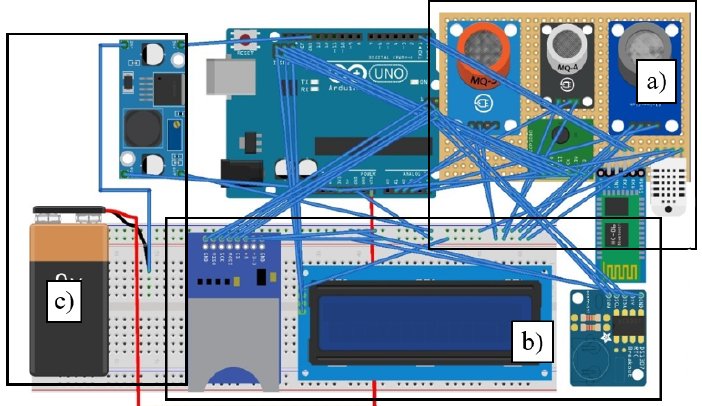
Figure 3. Arduino microcontroller with main block (approximate layout) ( a ) gas sensors (MQ2, MQ4 and MQ135) and temperature, humidity, and Bluetooth module; ( b ) real-time clock, SD card reader, and LCD; ( c ) current regulator and batteries.